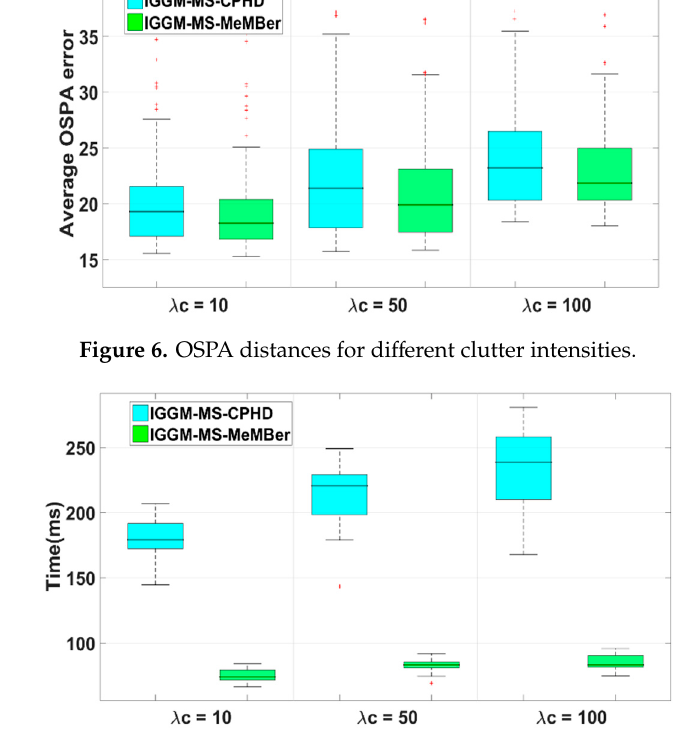
Figure 7. Average running times for different clutter intensities.